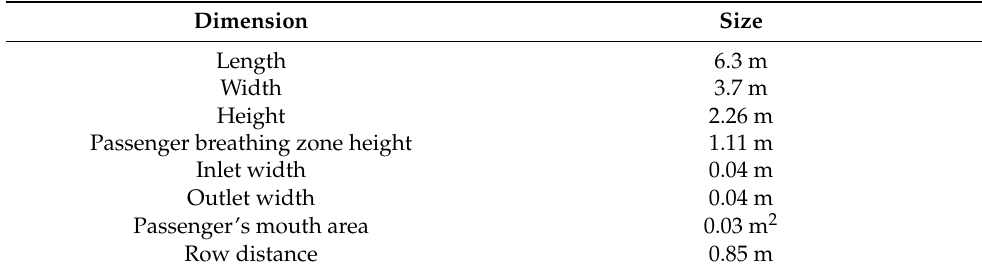
Table 1. Dimensions of the seven-row cabin